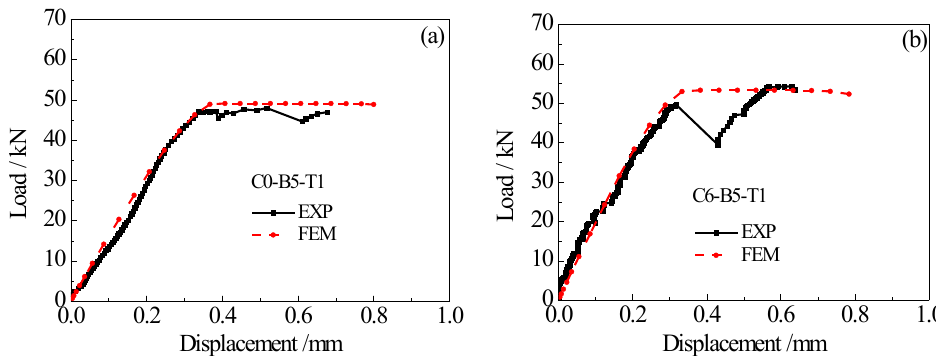
Figure 15. Comparison between the predicted and tested load-displacement curves: ( a ) specimen C0-B5-T1, ( b ) specimen C6-B5-T1.